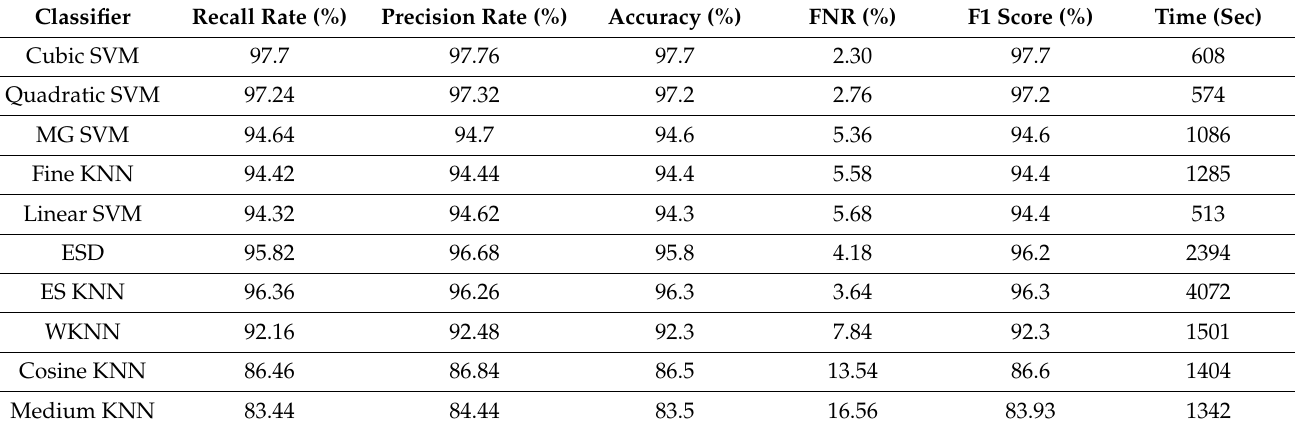
Table 5. Classification results of fine-tuned ResNet101 deep model after data